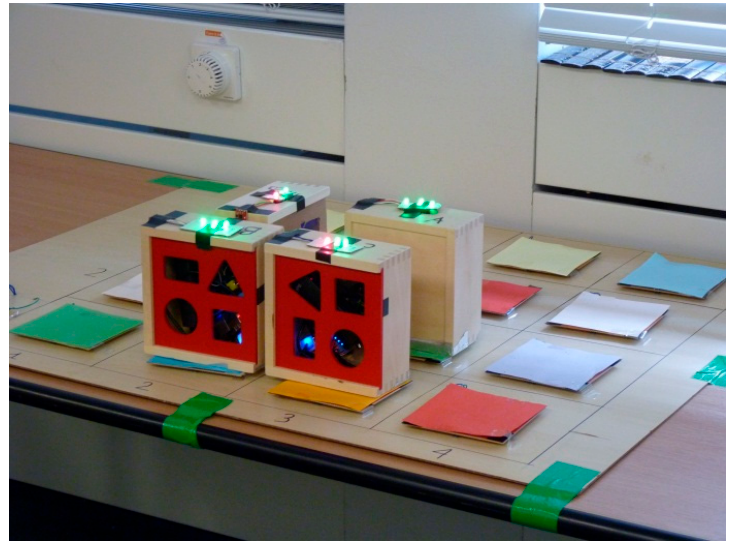
Figure 9. Visual feedback on networked objects [38].